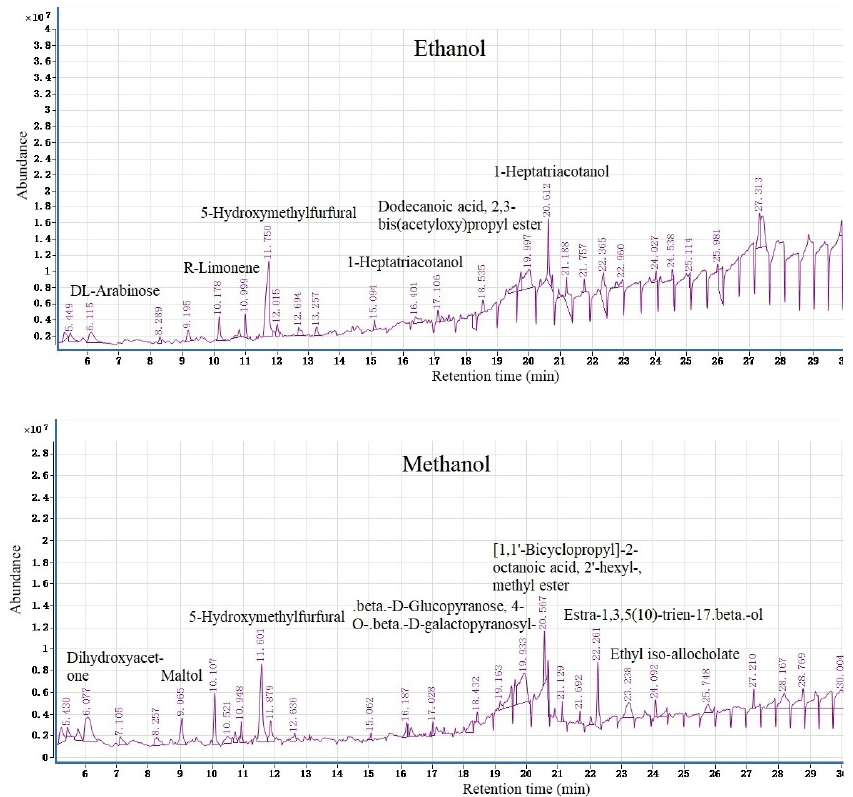
Figure 2. Total ion chromatogram of the A. Bunge leaves ethanol and methanol samples.